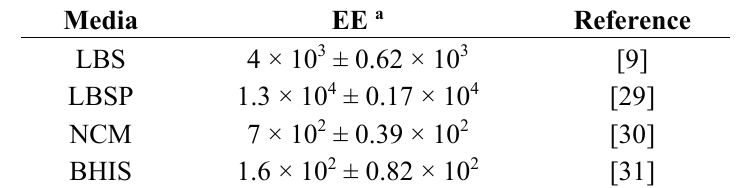
Table 1. Effect of growth media on the electroporation efficiency of B. subtilis